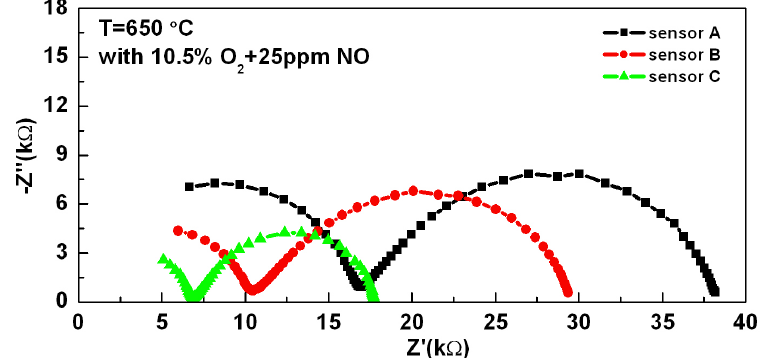
with 25 ppm NO present with N 2 2